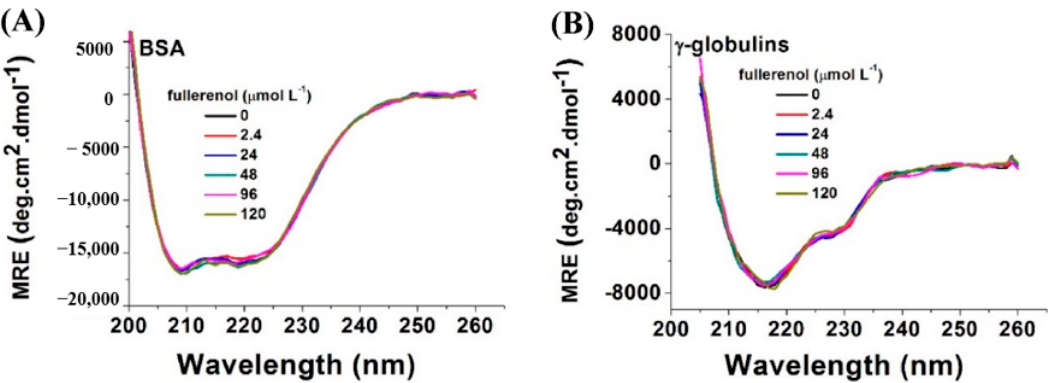
Figure 5. CD spectra of BSA ( A ) and γ -globulins ( B ) in the presence of di ff erent concentrations of fullerenol. With the addition of fullerenol the characteristic bands of BSA and γ -globulins did not show significant changes, suggesting that fullerenol did not induce any perturbations in the protein secondary structure. Reprinted from [97], with permission from